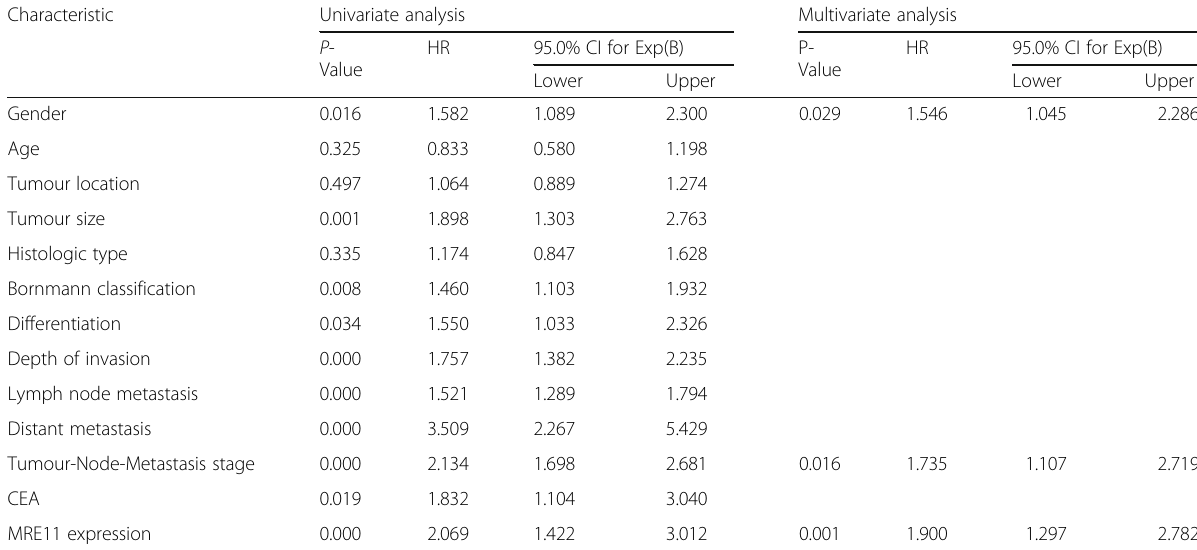
Table 3 Cox proportional-hazard regression analysis for Overall Survival